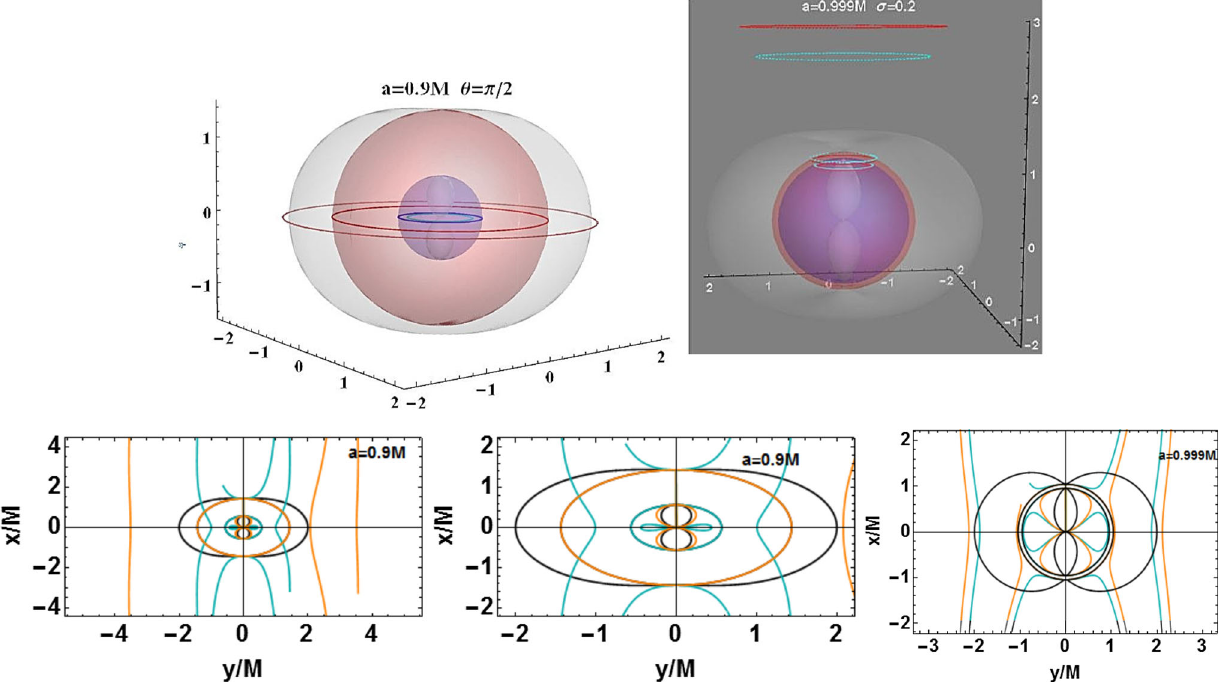
Fig. 15 Horizon frequency solutions of the MBs in the exterior region are horizontal lines of the extended plane in Fig. 2. The plots show, for fixed plane σ ≡ ( sin θ) 2 , the inner and outer horizons, the inner and outer ergosurfaces, the circle in the outer horizon, (red) on the inner horizon (blue) and orbital solutions with frequency of the inner (blue) and outer (red) horizon. In the frame we use, the BH Kerr ring sin-